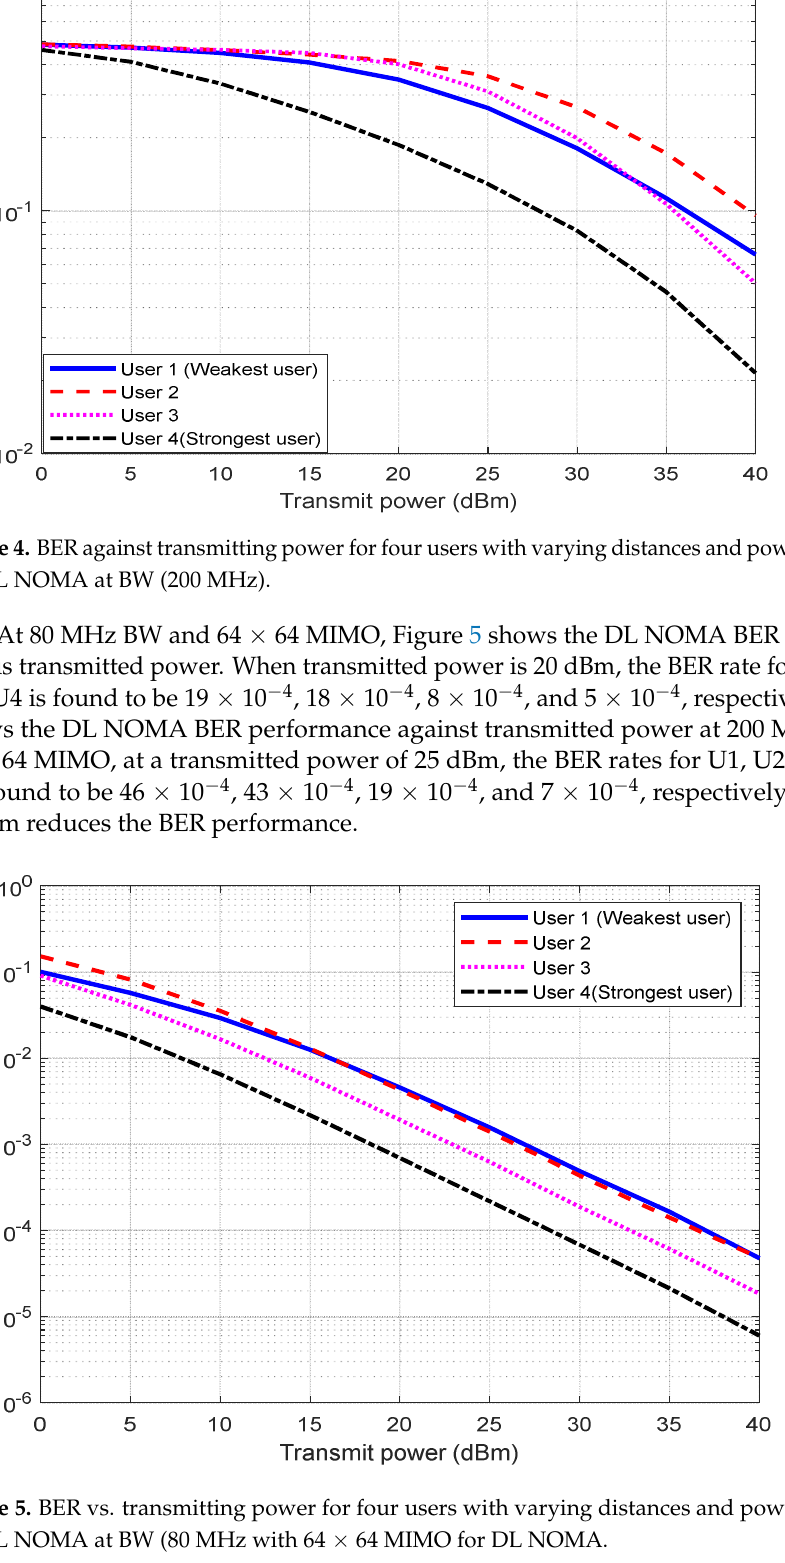
Figure 3. BER vs. transmit power for four users with varying distances and power coefficients, for DL NOMA at BW (80 MHz).